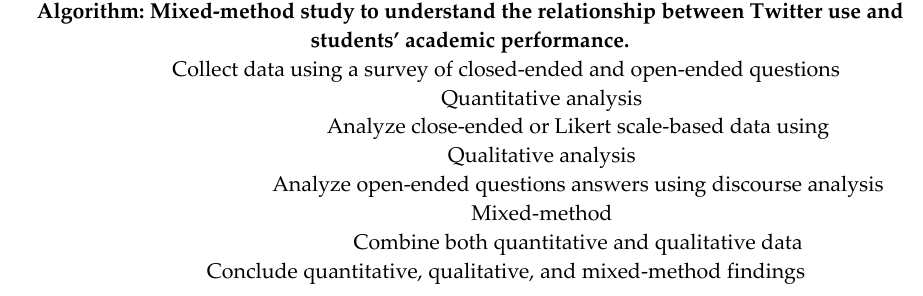
Figure 2. The algorithm that guided this study.